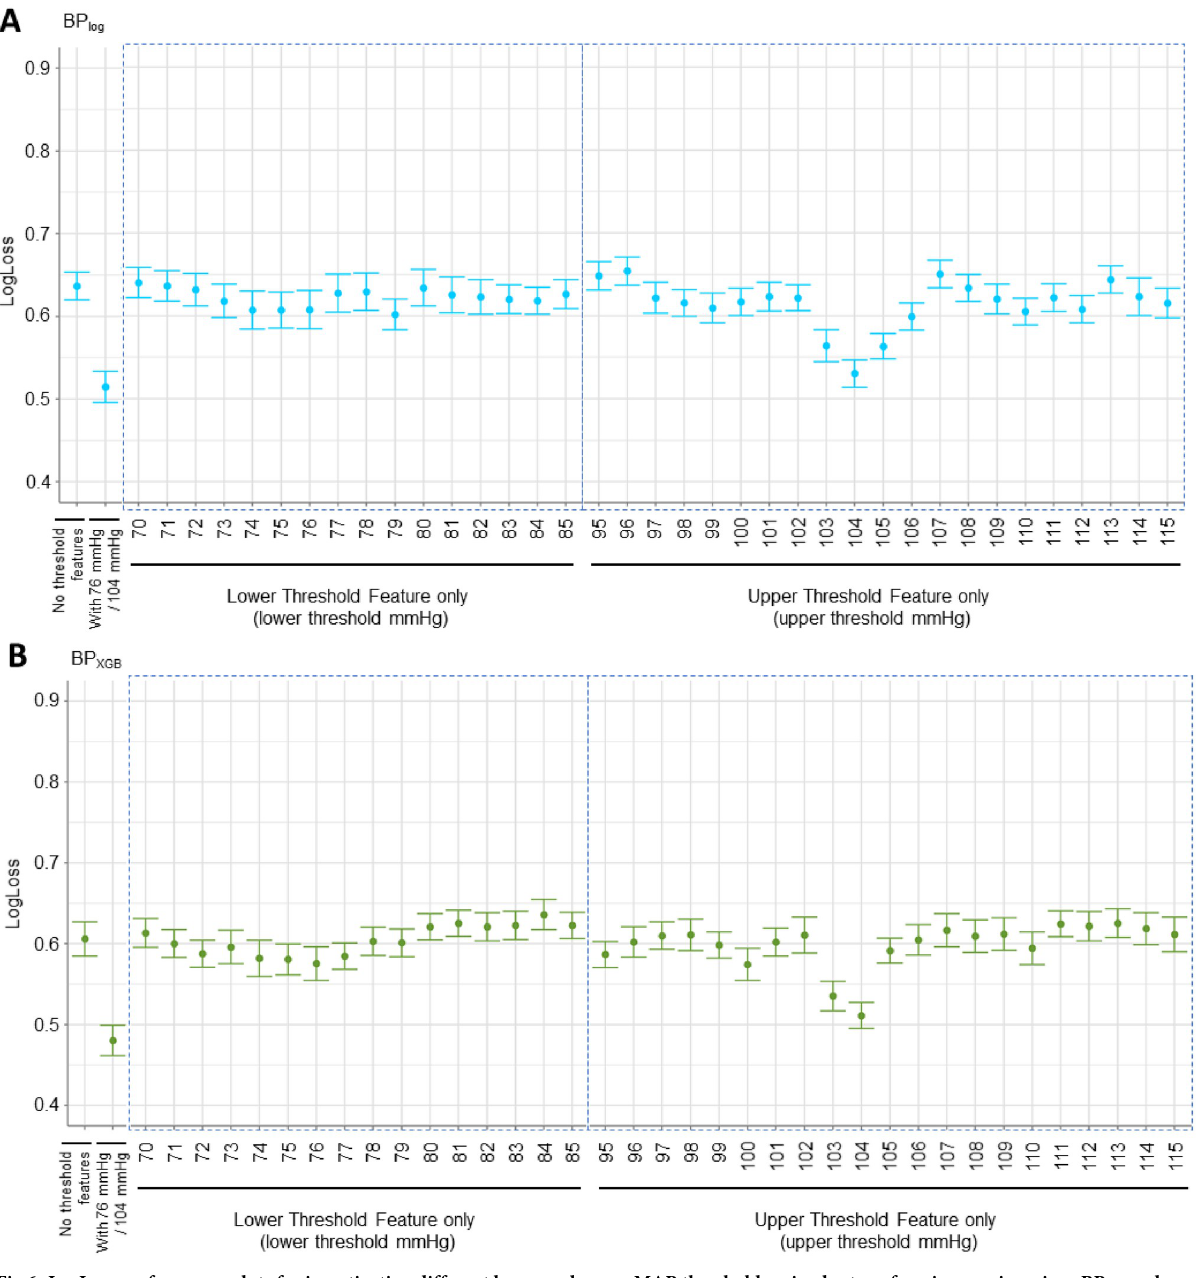
Fig 6. LogLoss performance plots for investigating different lower and upper MAP thresholds using best-performing parsimonious BP log and BP XGB models. (A) With BP log , we observe that the lower threshold values of 74, 75, 76, and 79 mmHg performed the best of the lower thresholds. The upper threshold values of 103, 104, and 105 mmHg performed the best of the upper thresholds. Notably, the best-performing upper threshold feature (104 mmHg) resulted in a larger improvement to model performance compared to the best-performing lower threshold feature (79 mmHg). (B) With BP XGB , the values of 74, 75, and 76 mmHg performed the best of the lower thresholds, and the values of 103 and 104 performed the best of the upper thresholds. Similar to BP log , the best-performing upper threshold feature (104 mmHg) resulted in a larger improvement to model performance compared to the best-performing lower threshold feature (76 mmHg).